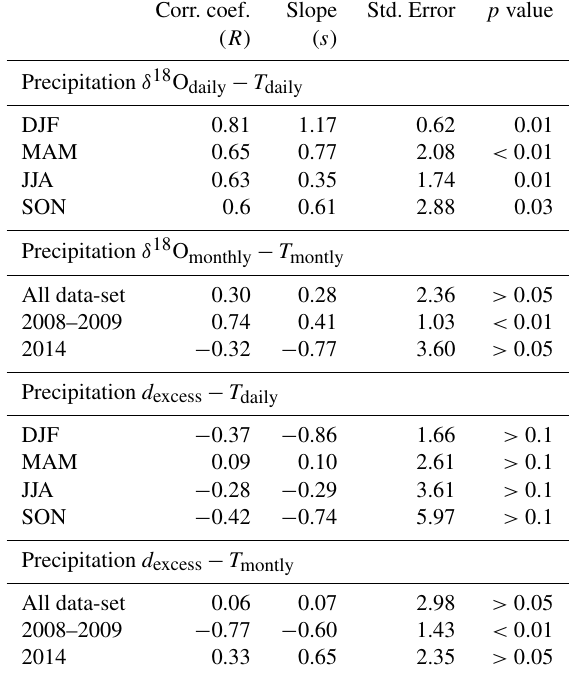
Table 3. Statistical correlations and linear regression significance of the δ 18 O and d excess –temperature relationship for precipitation samples. The slope and standard error are related to the linear re- gression constructed from the isotope–temperature regressions at daily and monthly scales. Corr.